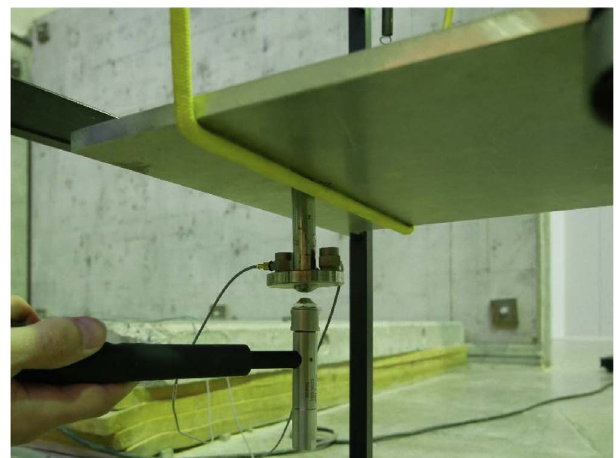
Figure 18. Suspended source, with two mounted accelerome- ters at one source foot and an impact hammer for excitation for the measurement of the source mobility (the impact hammer is not used for the measurement of the free velocity).